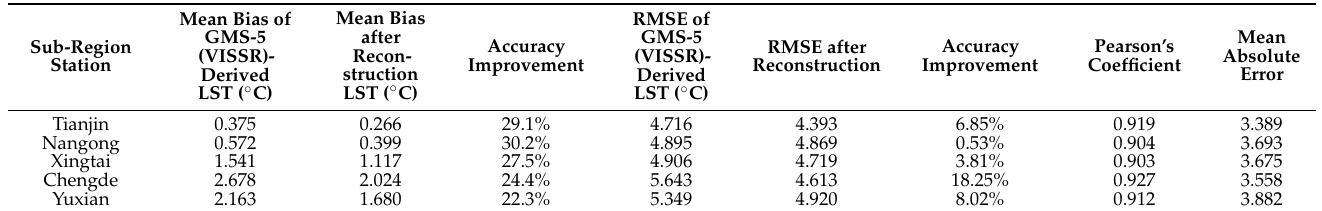
Table 1. The statistics of the optimized surface temperature data compared to the original data from five stations in the Beijing–Tianjin–Hebei region in 2002.